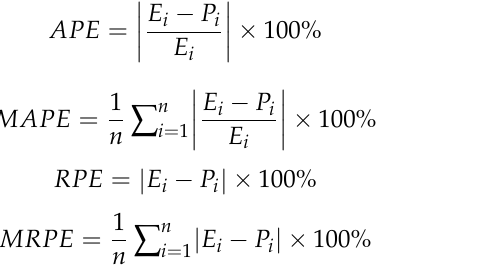
Figure 17. The correlations between S and PCA : ( a ) The bending angle; ( b ) The distance ratio.